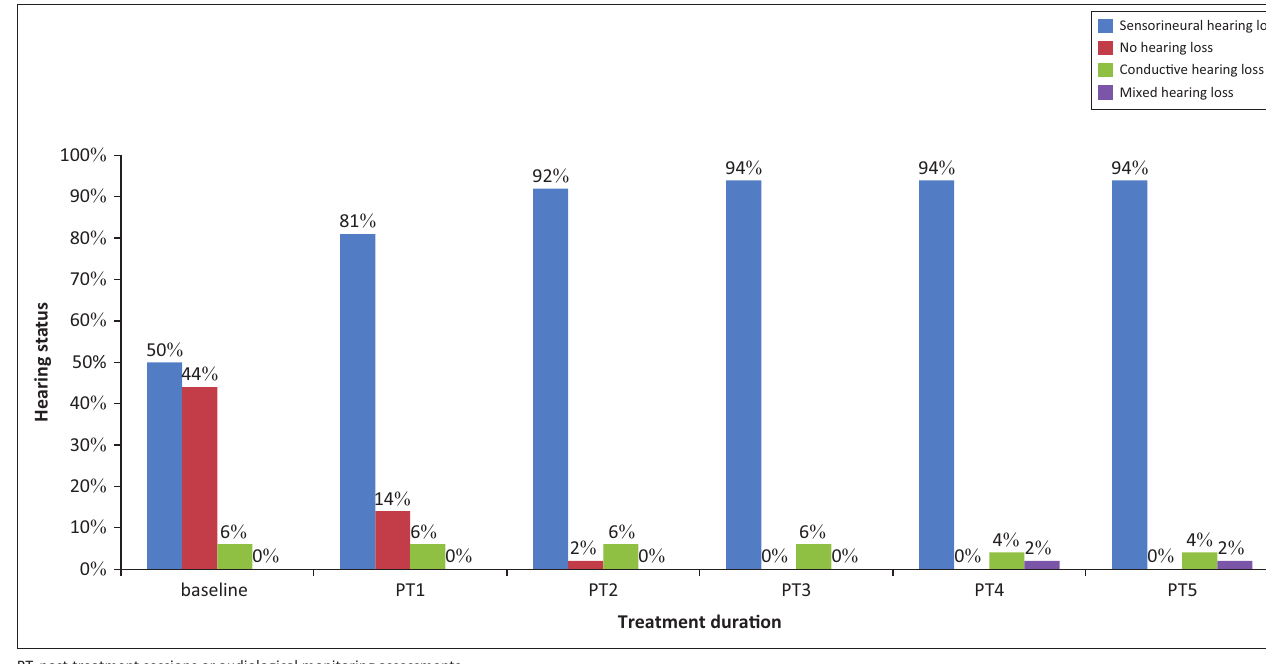
FIGURE 7: Ultra-high frequency threshold changes over treatment duration.